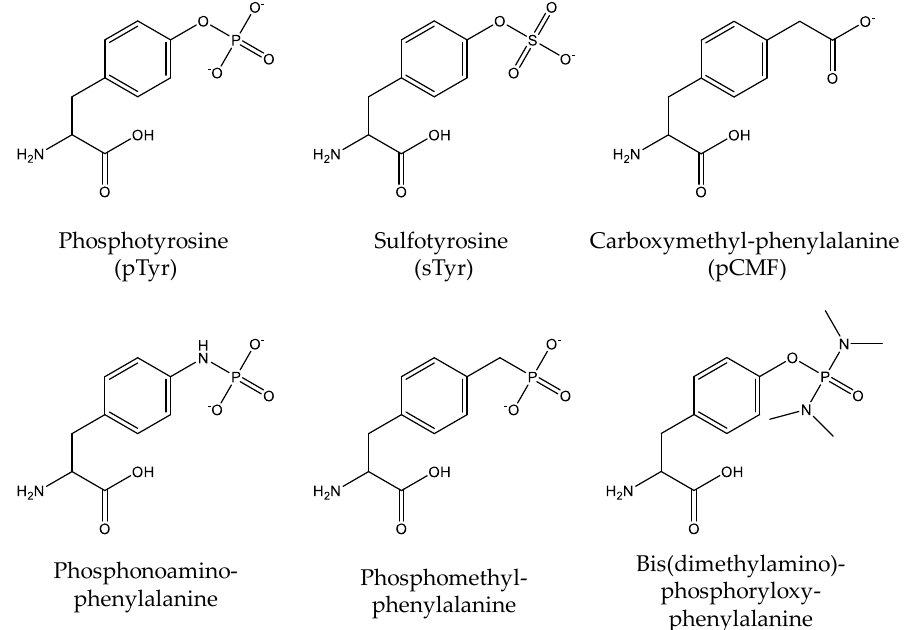
Figure 7. The structures of phosphotyrosine (pTyr) and its analogs, including sulfo-tyrosine (sTyr), p -carboxymethyl-phenylalanine ( p CMF), p -(phosphonoamino)-phenylalanine, 4-phosphomethyl- phenylalanine and 3-4(bis(dimethylamino)phosphoryloxy) phenylalanine.